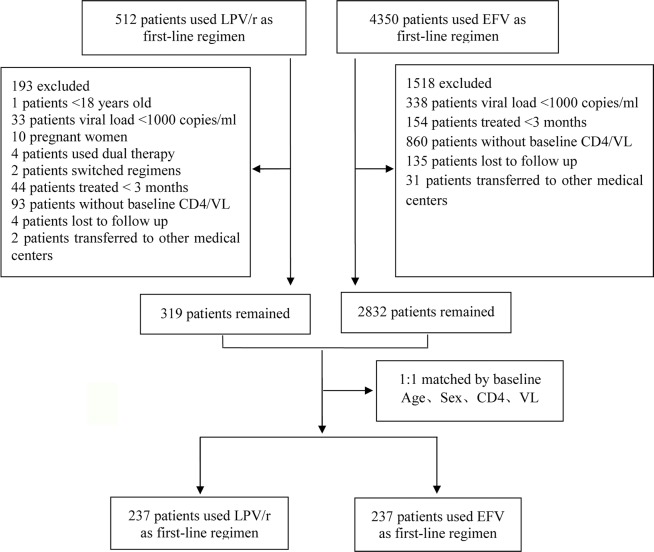
Flowchart for patient selection.